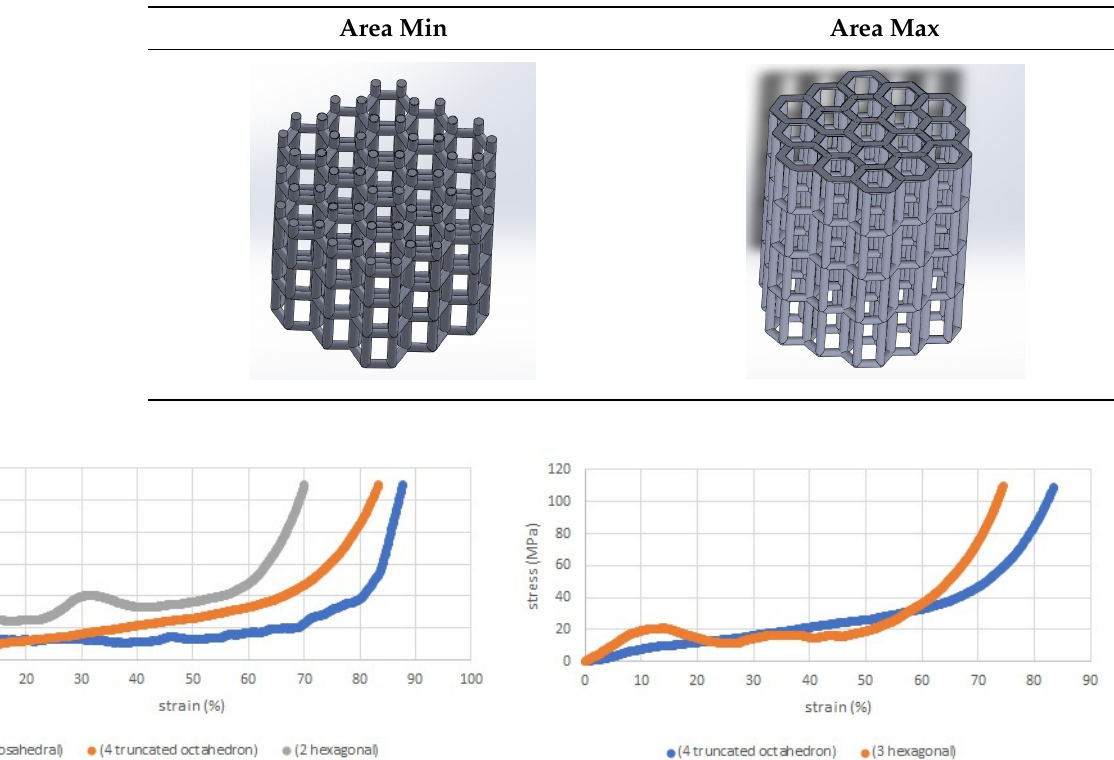
Table 2. Minimum and maximum area.